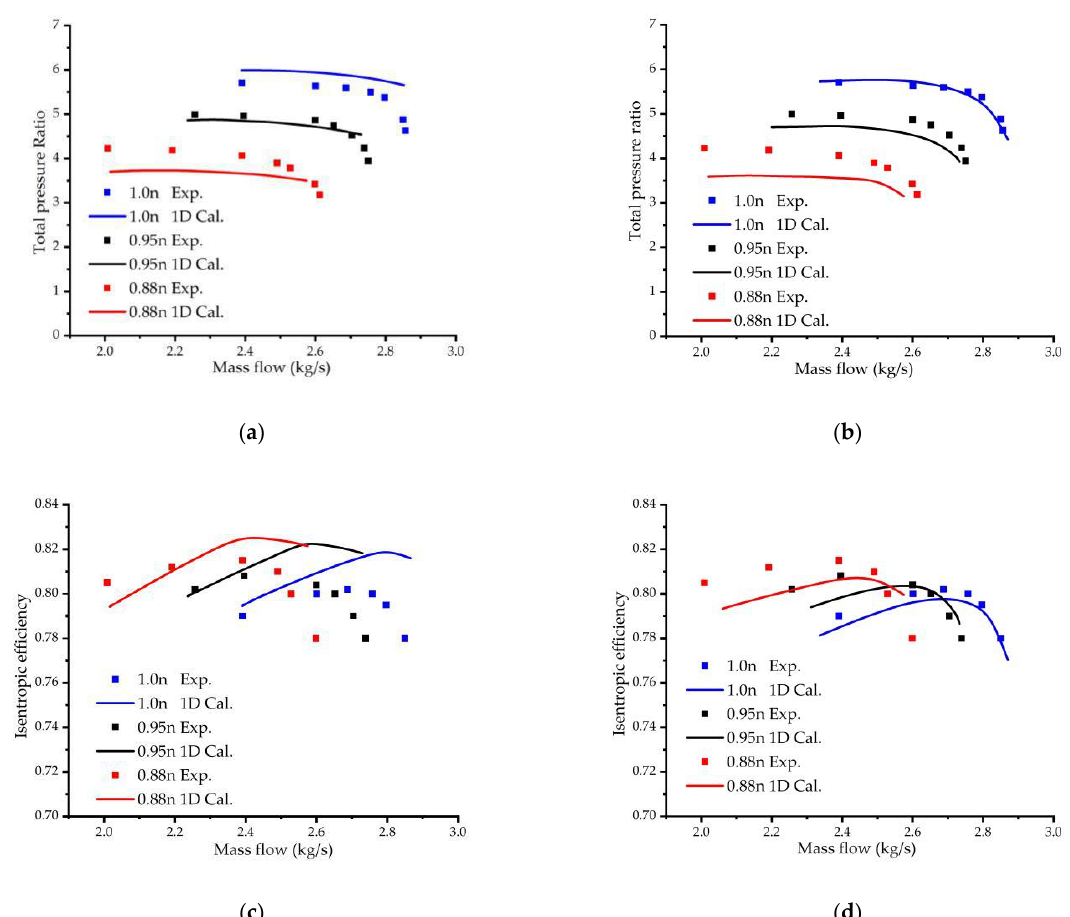
Figure 14. Comparisons of the 1D predicted performance before and after optimization for the SRV2-O impeller: ( a ) Total pressure ratio before optimization; ( b ) Total pressure ratio after optimization; ( c ) Efficiency before optimization; ( d ) Efficiency after optimization.